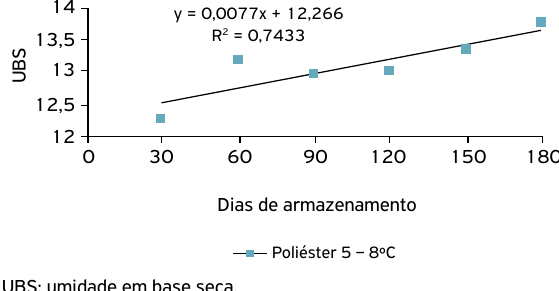
Figura 7. Conteúdo de água (umidade em base seca) de uma mistura granulada com conídios B. bassiana acondicionada em embalagens de poliéster metalizado durante 180